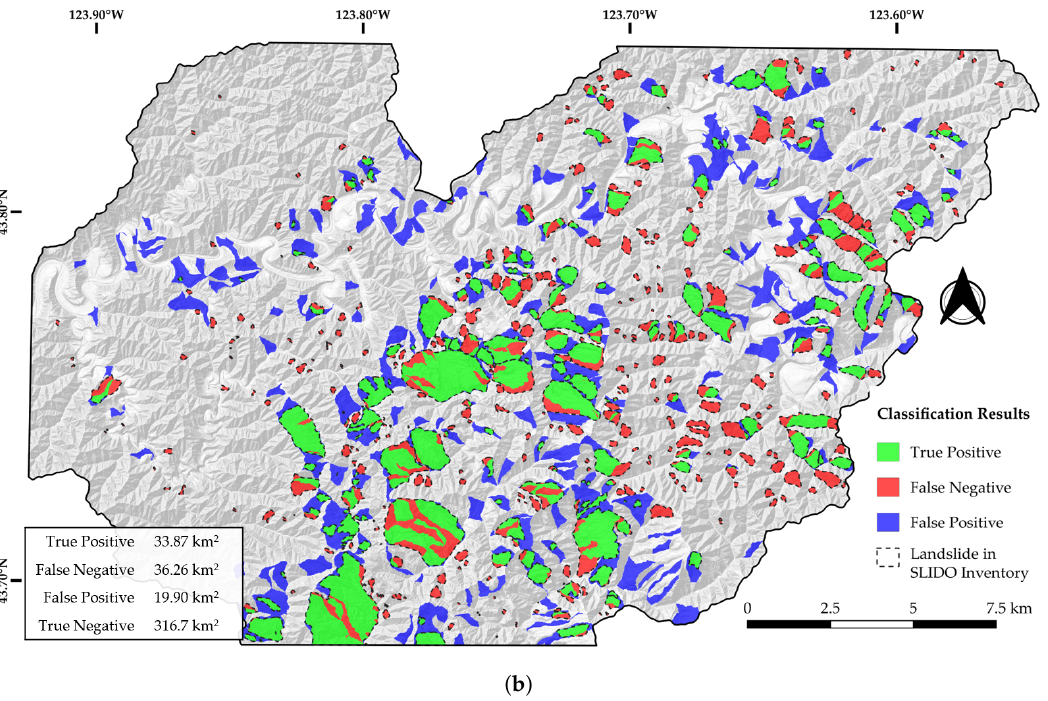
Figure 6. ( a ) Example of SU objects for two section of the study area. The landslide affected SUs have more than 25% of their area overlapping landslides from SLIDO inventory. ( b ) Result of object-based method using boosted Artificial Neural Networks (applied to testing area). All the maps are in UTM Zone 10N with WGS 84 datum